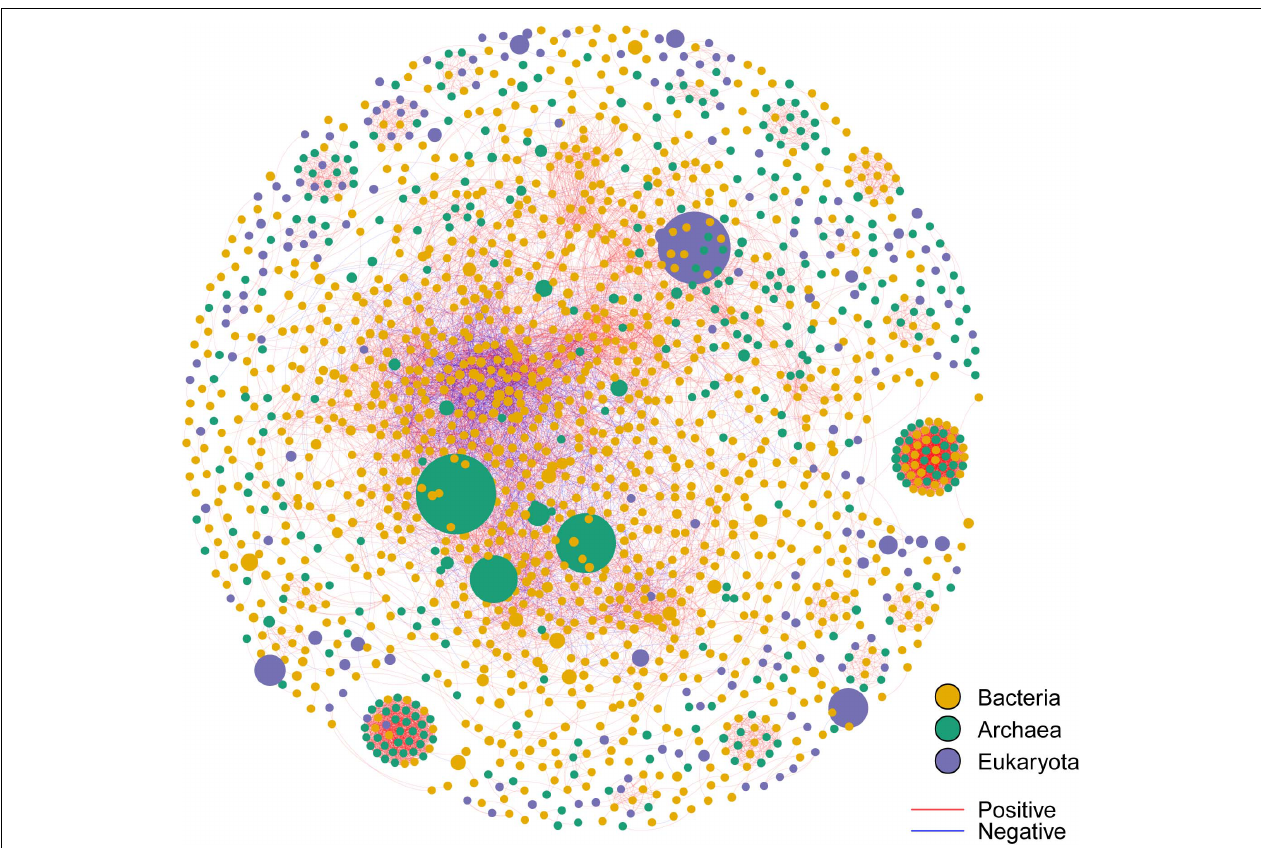
FIGURE 6 | The co-occurrence network for the bacterial OTUs, archaeal OTUs, and eukaryota OTUs in the alpine meadow’s soils of the Qilian Mountains. The size of each node is proportional to the relative abundance of the OTU; nodes with the same color belong to the same domain; the links in red color represent positive interaction, and those in blue represent negative interaction. OTUs with a relative abundance of less than 0.05% were eliminated. The thickness of each edge (i.e., each connection between nodes) is proportional to the magnitude of the correlation coefficient (Spearman r > ± 0.6 and P < 0.01).